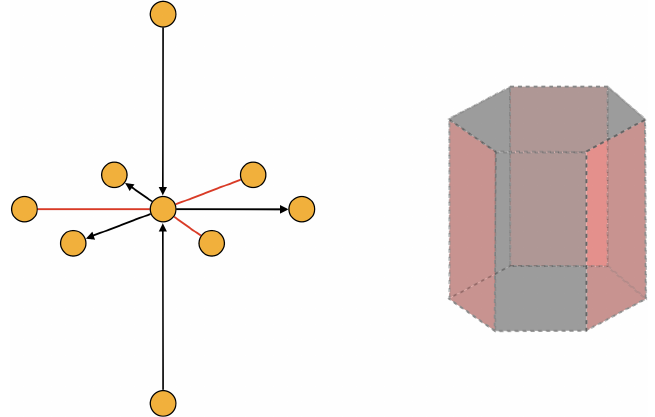
= n F = 3 and its dual cylindrical brick. k k,out